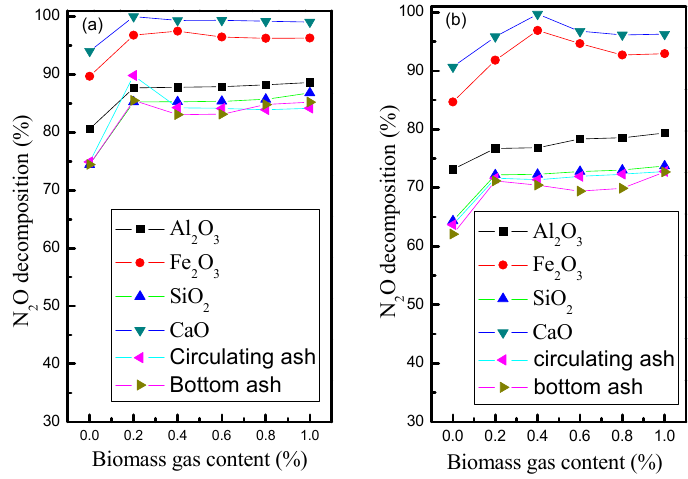
Figure 9. Influence of biomass gas on heterogenous N content: ( a ) N O = 2000 ppm; ( b ) N 2 10 mm).